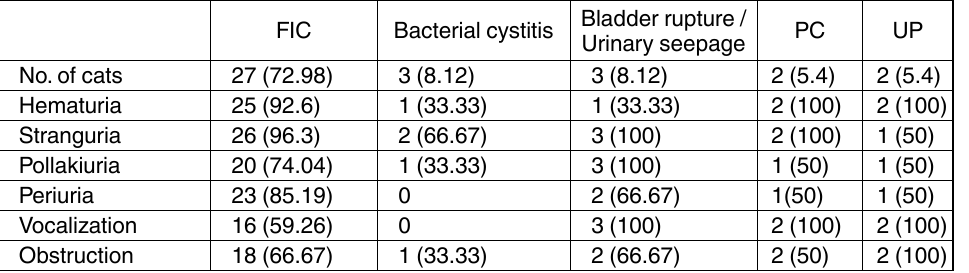
table 3 . Number (per cent) of cats with FLUTD which exhibited different clinical